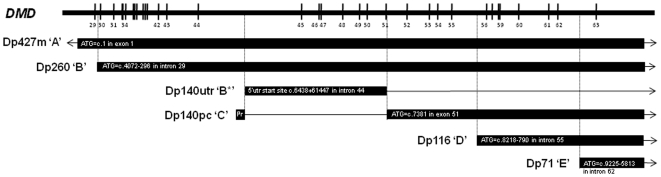
Genomic organisation of alternate dystrophin isoforms.The relationship between the abbreviated nomenclature used for the isoforms affected by a DMD mutation and the structure of the Dp427m, Dp260, Dp140 and Dp116 isoforms of the dystrophin gene. The black vertical lines represent the coding exons of the dystrophin gene with exon numbers given below. The positions of the initiator Methionine (ATG), untranslated region start site (utr) and promoter (Pr) are depicted. The figure demonstrates that exons 45–50 together with the 5′ region of exon 51 lie within the 1.041Kbp 5′UTR of Dp140 as well as within the coding regions of Dp260 and Dp427. The numbering used is with respect to intron/exon structure of Dp427m NM_004006.2 and the Human Genome reference sequence of Ensembl build 52 (Dec 2008) implemented in Alamut version 1.5.